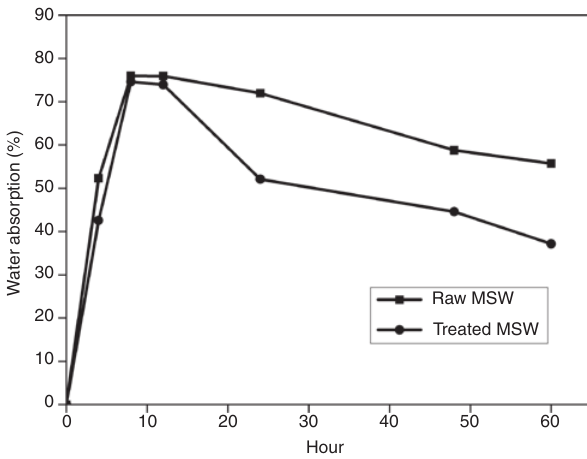
Figure 8 Water absorption properties of raw and treated